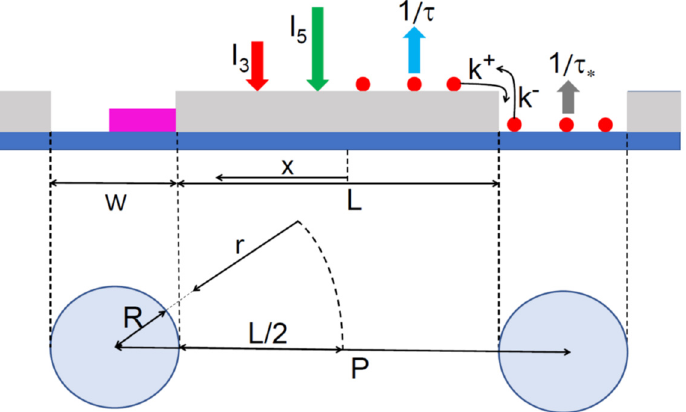
Figure 1. Geometry of regular 1D slits of width W , or 2D arrays of pinholes of radius R , separated by pitch P . The coordinates x in 1D geometry and r in 2D geometry originate from the central band between the openings. The III-V material is deposited from atomic fluxes of group III and V elements I 3 and I 5 . The effective lifetimes of group III adatoms in the openings and on the mask are τ ∗ and τ , respectively. The rate constants for the transfers of group III adatoms from mask to openings and from openings to mask are k + and k − ,